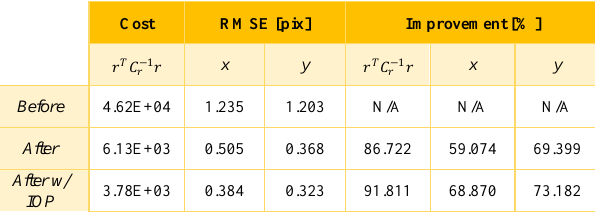
Table 4: Reprojection errors of fluoroscopic system 2